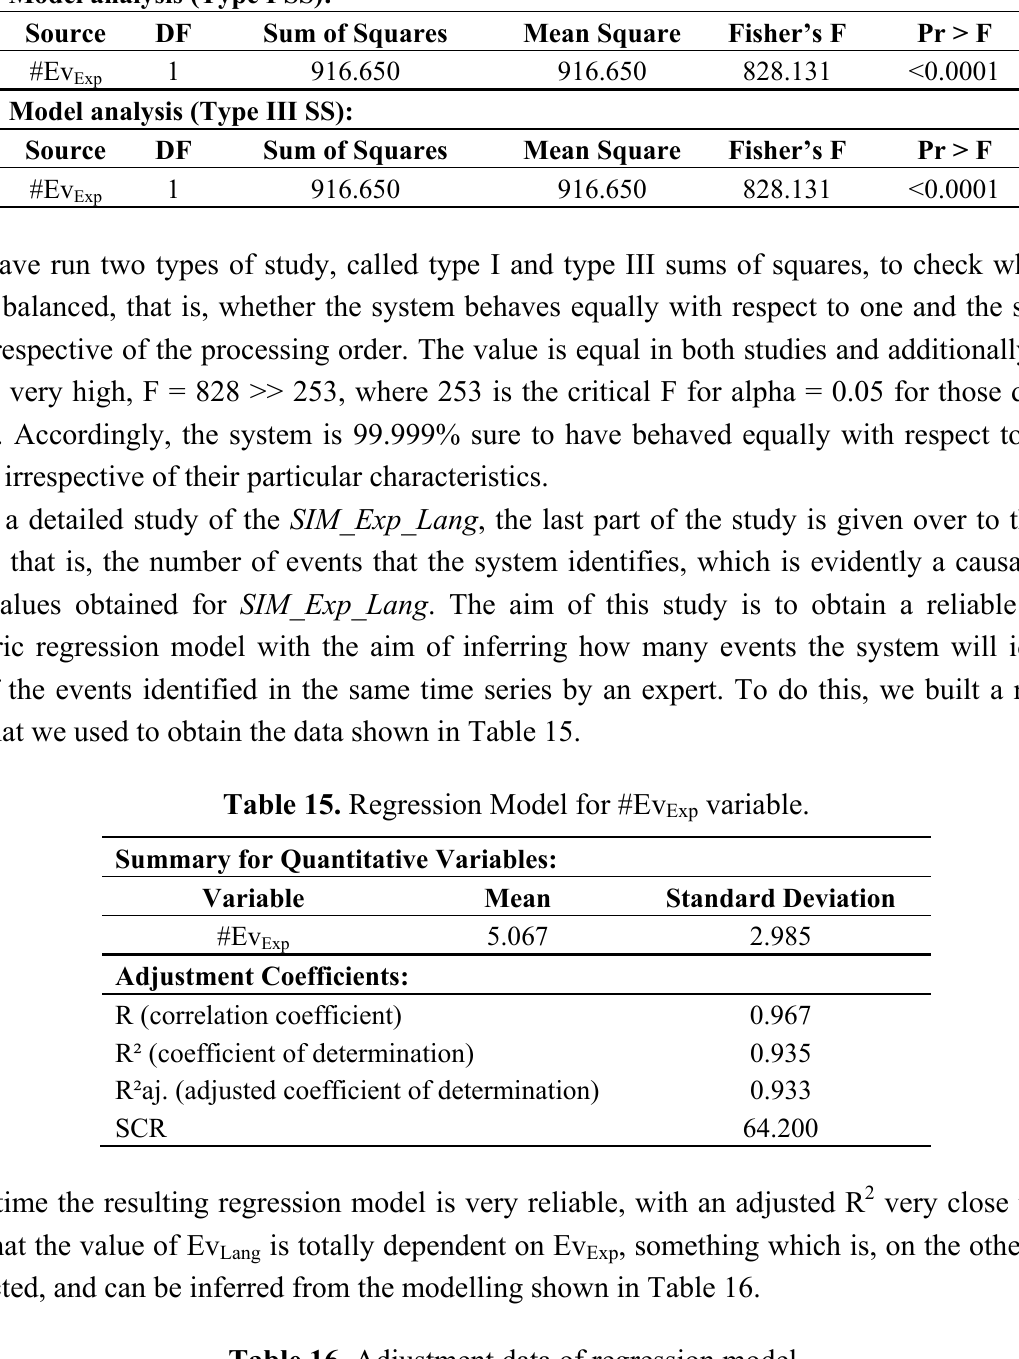
Table 16. Adjustment data of regression